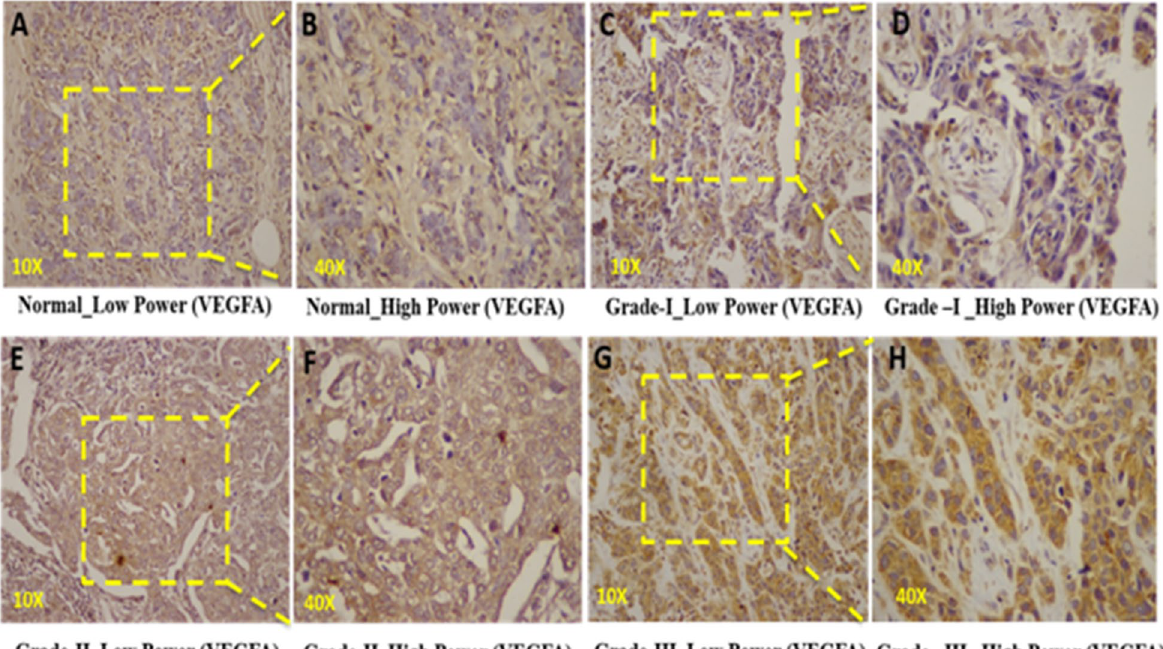
Fig. 3 Immunohistochemical expression of VEGFA with increasing grade in breast carcinoma. The expression of VEGFA was mostly cytoplasmic. A Normal tissue (10X), B Normal tissue (40X), C Grade I(10X), D Grade I(40X), E Grade II(10X), F Grade II(40X), G Grade III (10X), H Grade III